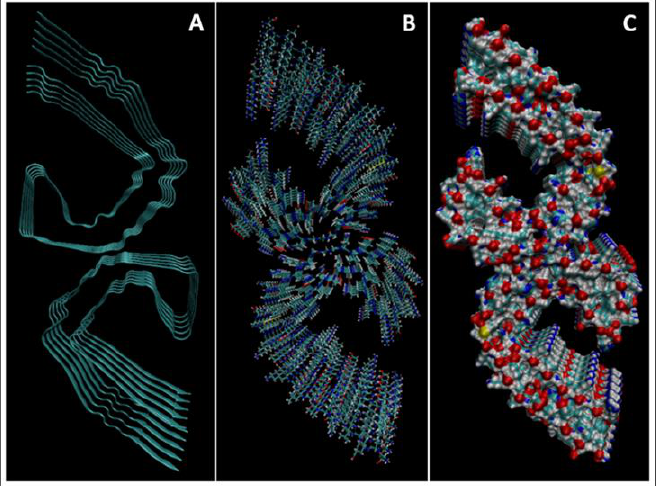
Figure 22. ( A ) A cartoon model, ( B ) a bonds model, and ( C ) a surface model of PHF tau.